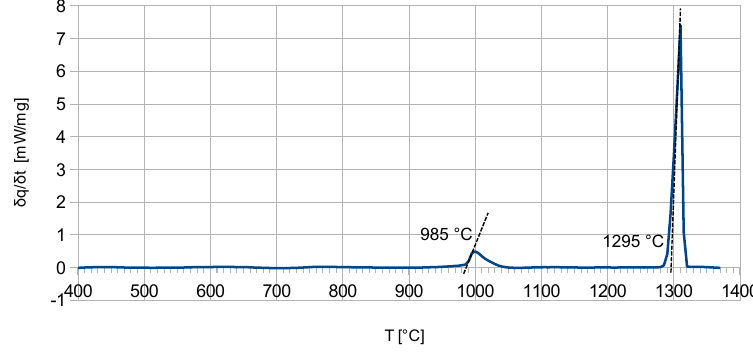
Figure 2. Calorimetric measurement data for the reference alloy Ni-22%Cr-10%Al: heating curve after homogenization.